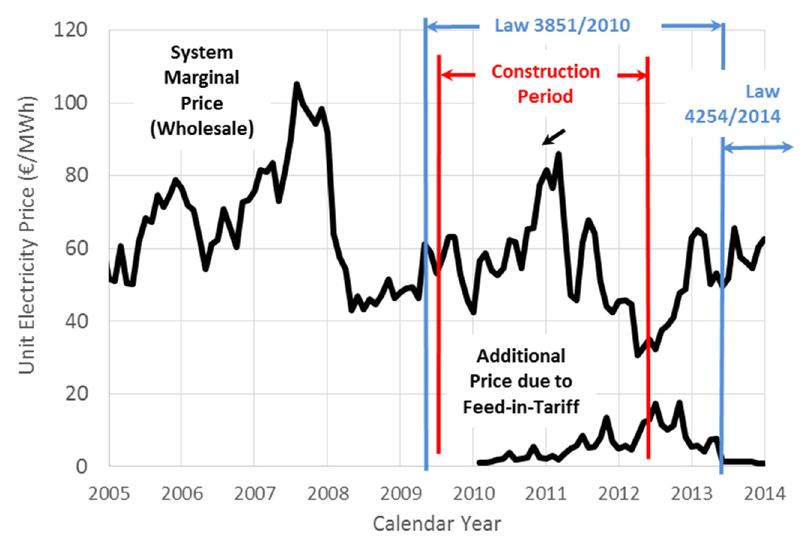
Figure 7. Comparison of surcharge of photovoltaic incentives to electricity consumers with the system marginal